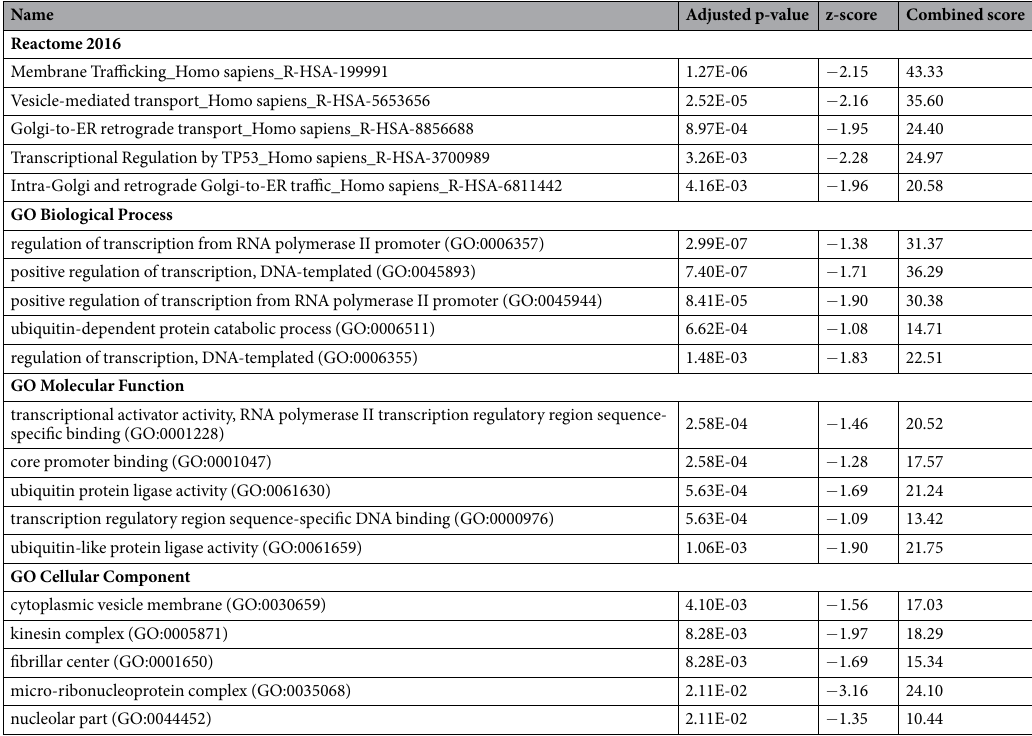
Table 3. Functional annotation of miRNA target genes. Enriched gene sets were identified using Enrichr 57,58 . GO: gene